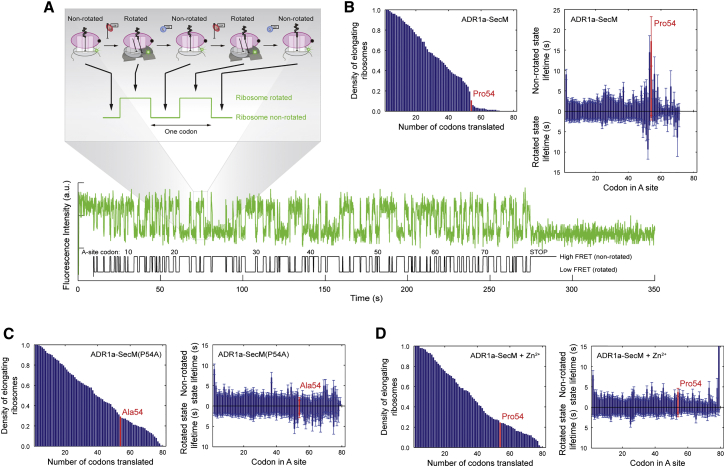
Folding of the ADR1a Domain Prevents Ribosomal Stalling on the SecM AP(A) The dynamics of ADR1a-SecM (L = 24; Δ1–158) translation were assayed in real time using inter-subunit FRET between Cy3B and BHQ-2. Transition from low Cy3B intensity (high FRET) to high intensity (low FRET) and back to low intensity again, as a consequence of the inter-subunit rotations, reports on one elongation cycle (i.e., peptidyl transfer and subsequent translocation). The time-trace example shows how one ribosome translates the whole ADR1a-SecM (L = 24) ORF in a construct in which the critical C-terminal Pro54 in the AP has been changed to Ala.(B) Survival plot (left) and lifetimes of the rotated and non-rotated states (right) for each individual codon summarized from ADR1a-SecM (L = 24) translation time traces (n = 149). The critical Pro54 codon is shown in red for clarity.(C) Inter-subunit FRET data from elongation of an ADR1a-SecM (L = 24) construct in which the Pro54 has been changed to Ala (n = 147).(D) Inter-subunit FRET data from elongation of the ADR1a-SecM (L = 24) construct in the presence of 50 μM Zn2+ (n = 147). Lifetimes are fitted to single-exponential distributions. SEMs are indicated.See also Figure S3.